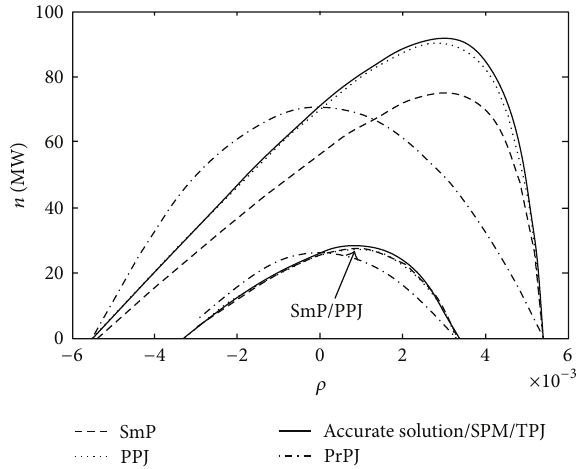
Figure 1: Variation of output power with time while inserting step reactivity 𝜌 0 = 0.5𝛽 and 𝜌 0 = 0.8333𝛽 .